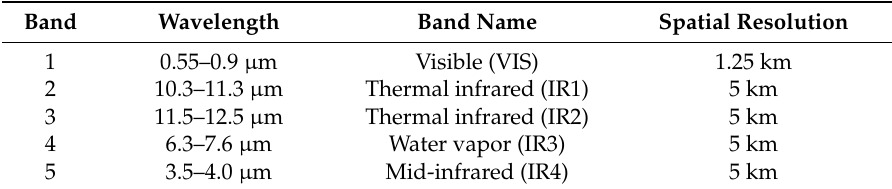
Table 1. bands information of FY-2G.